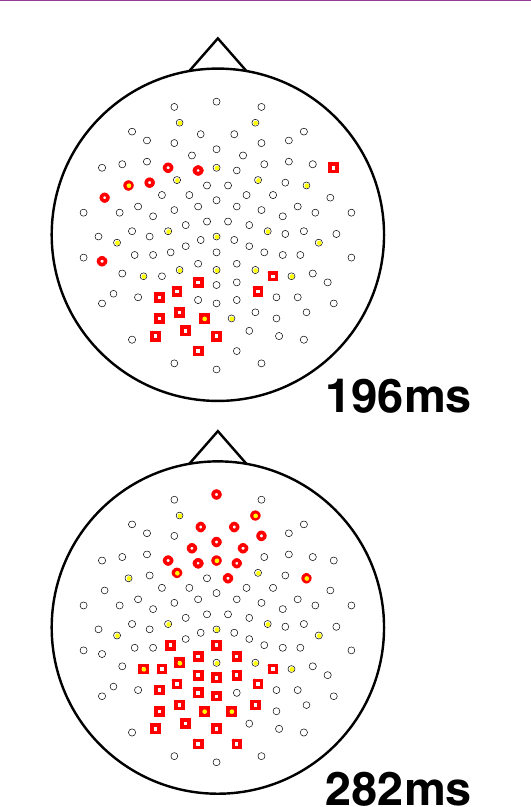
Figure 4. Topographic maps of statistically signifi cant interaction effects observed in this study. Two difference waves were computed: one for irrel- evant stimuli (high–low load) and one for target stimuli (again, high–low load). The resulting difference waves were compared using a t -test for each electrode at each time point, with a threshold of p < 0.05. The plots show all electrodes, with signifi cant electrodes shown in bold: bold squares show regions with more negative defl ection for this interaction while bold circles show positive defl ec- tions. In other words, the squares show regions where increasing load is related to stronger N1 amplitude for target versus irrelevant stimuli. Two representative time points are shown: one at 198 ms and one at 282